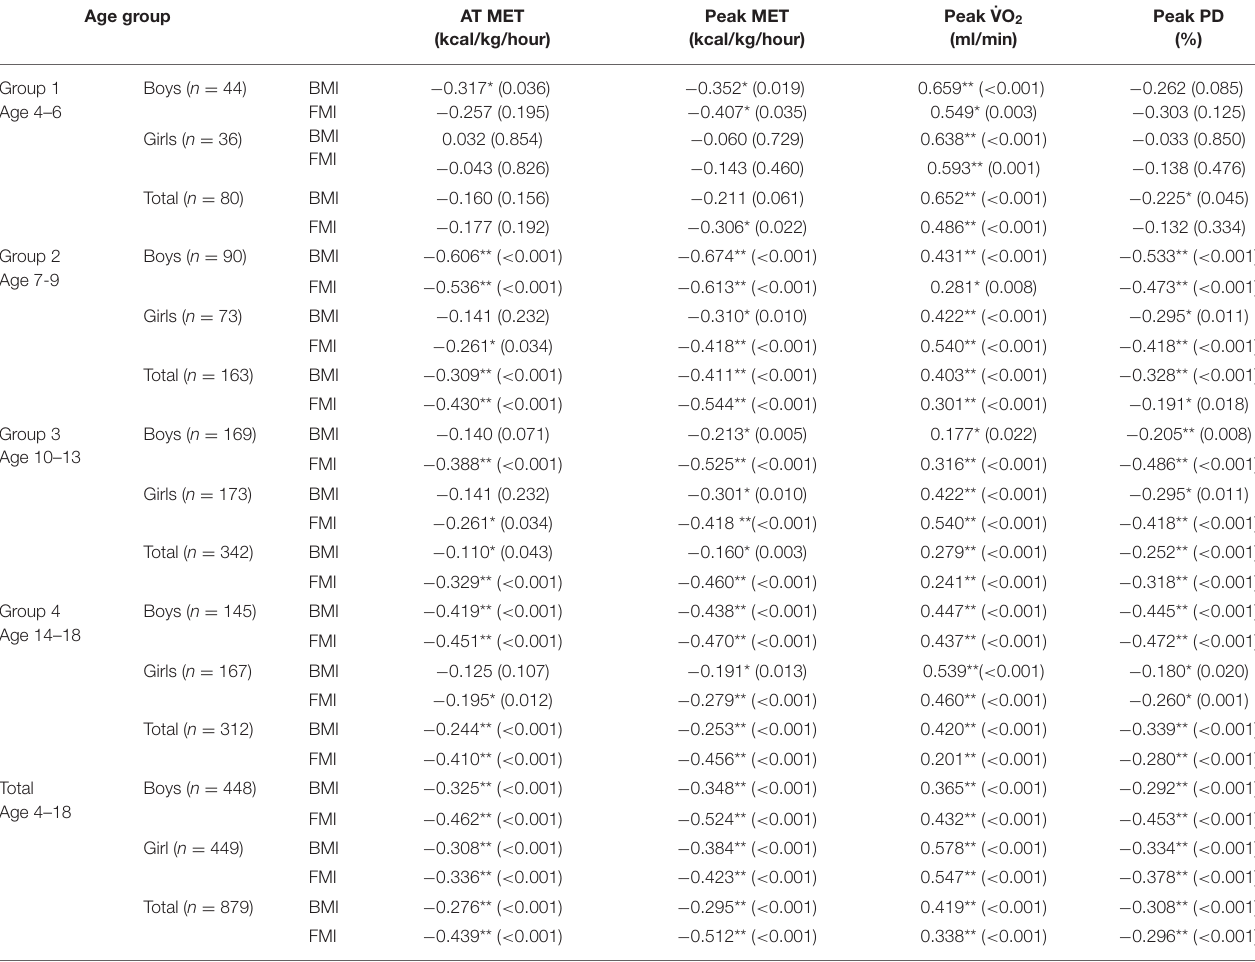
TABLE 3 | Correlation between body mass index, fat mass index, and performance of exercise test of children and adolescents. Age group AT MET